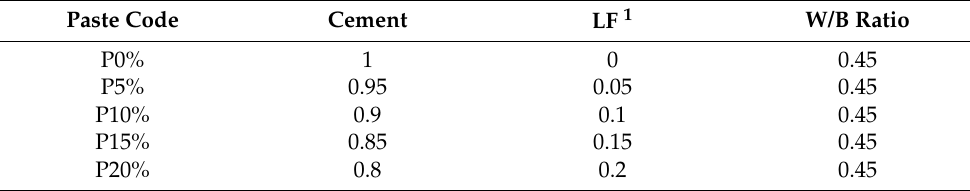
Table 3. Paste mix